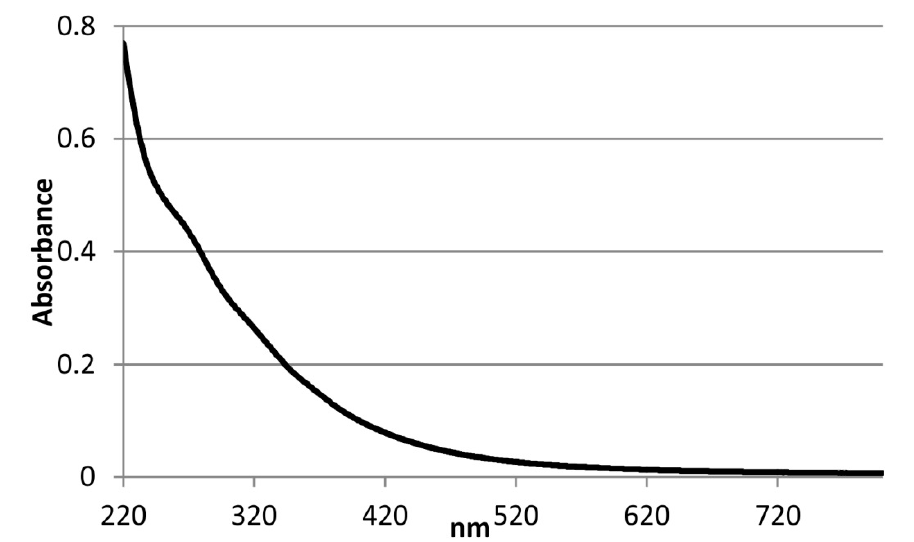
Figure 3. UV-Vis spectrum of the synthesized CNDs-DS.